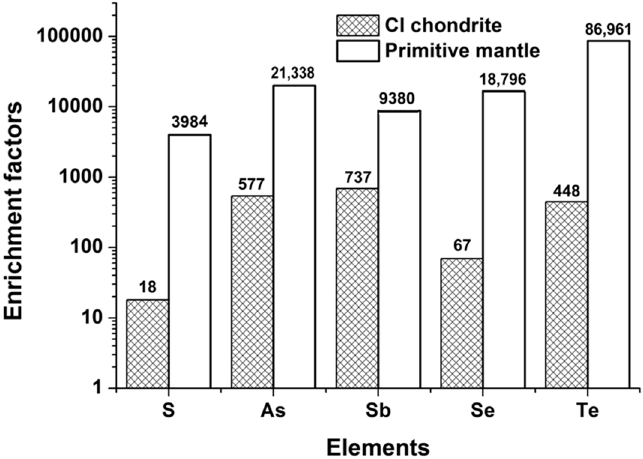
Figure 6. Enrichment factors for S, As, Sb, Se and Te compared to CI chondrite and primitive mantle. Data sources: Kueishantao sulfur matrix (this study); CI chondrite and primitive mantle [4].